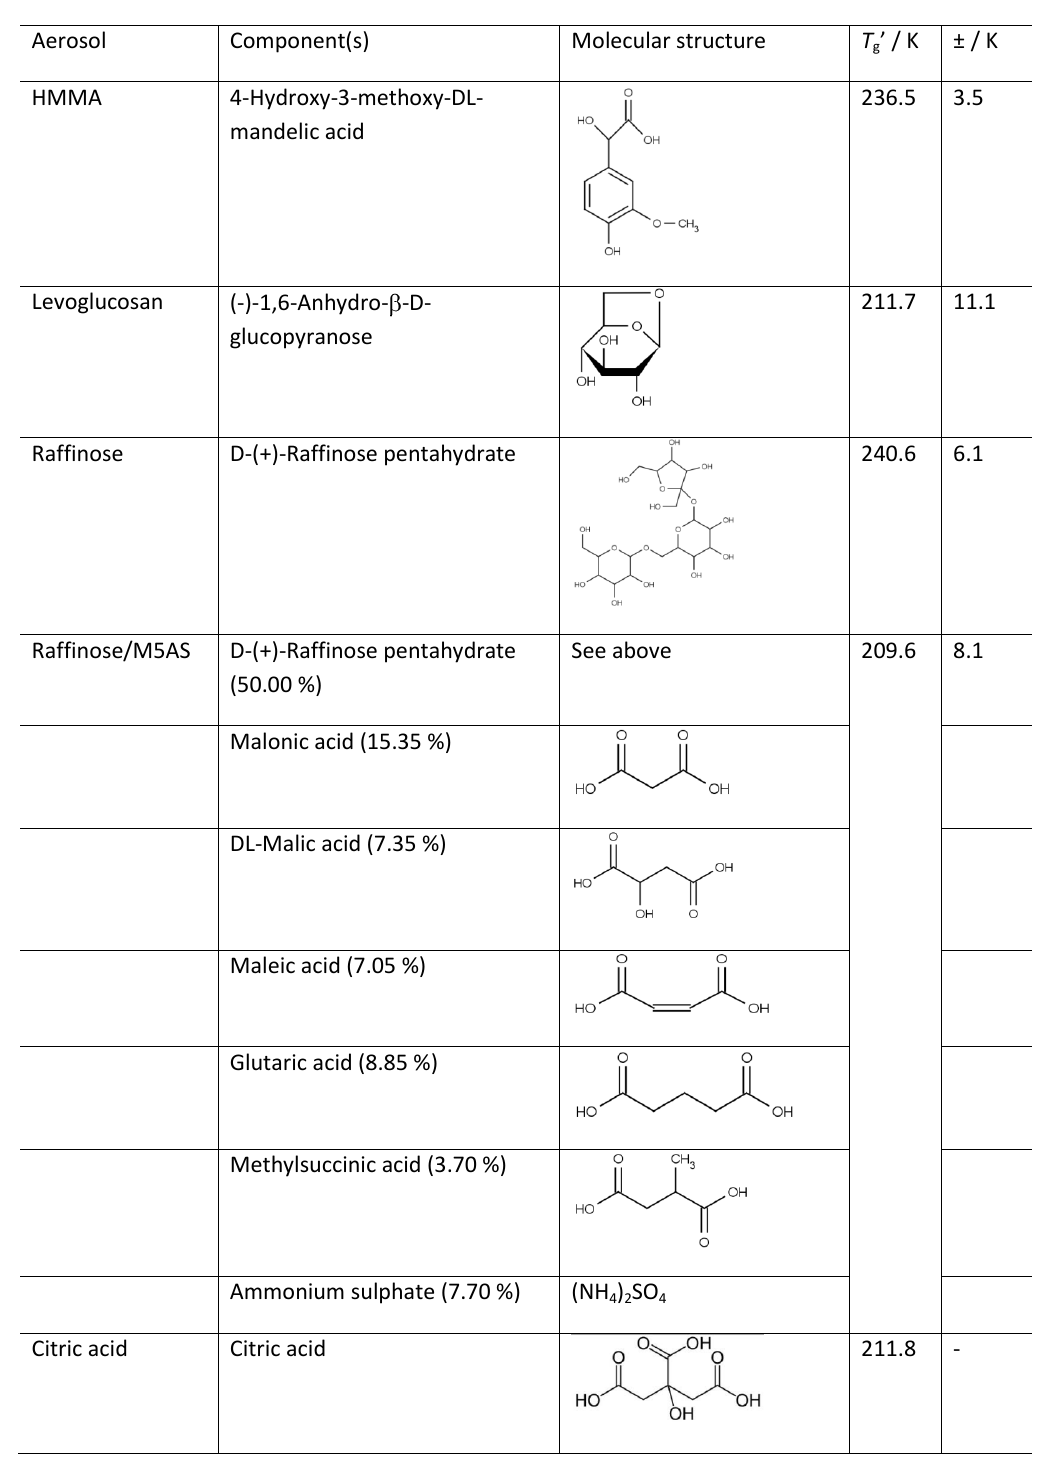
Table 1. Molecular structures of the glass forming components of the four aqueous aerosols examined in this study with associated T 0 g and uncertainties (Zobrist et al., 2008). The molecular structure and T 0 g of citric acid, a component of glassy aerosol previously tested by Murray et al. (2010b) has been included for comparison (note that no uncertainties in T 0 g were available for citric acid). The bracketed percentages next to the components of raffinose/M5AS aerosol indicate the individual species contribution by mass to the